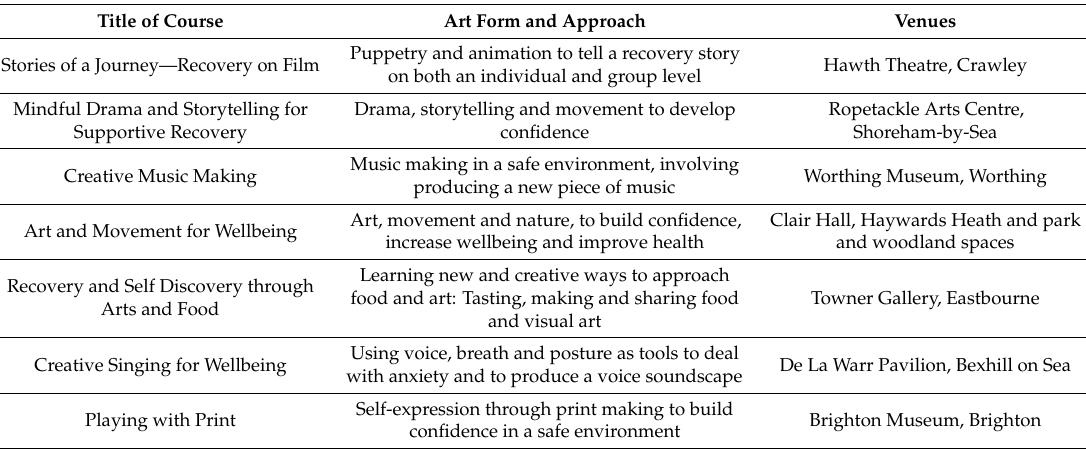
Table 1. Outline of arts courses